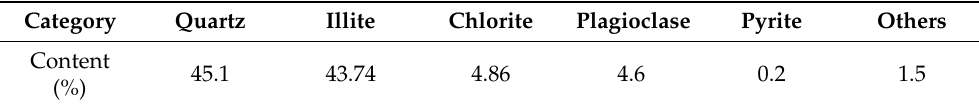
Figure 4. Microcracks and pores near mineral particles. ( a ) Mineral accumulation zone. ( b ) Quartz particles. ( c ) Microcracks near mineral particles.